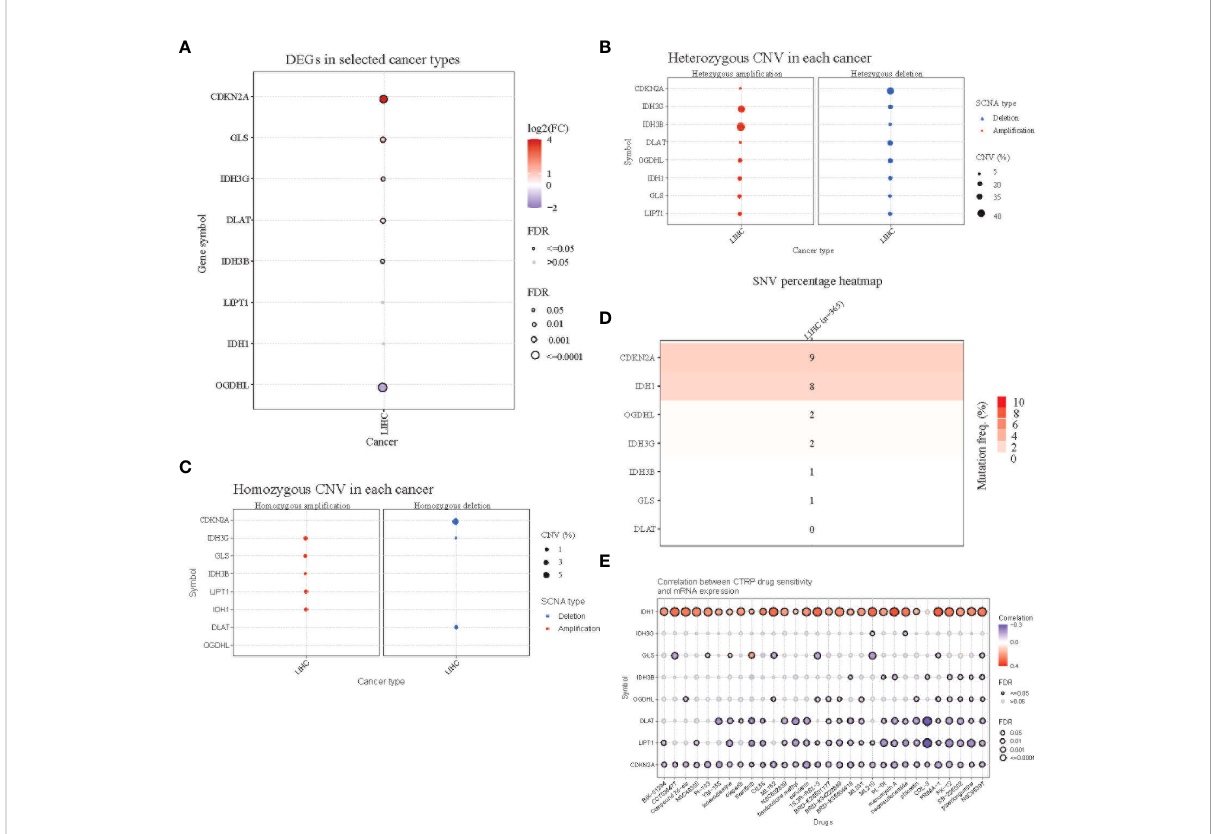
FIGURE 2 Mutation analysis of the 8-gene signature. (A) Differential expression of the eight genes in TCGA HCC tissues and normal adjacent tissues. Red (log2FC>1) indicates high expression, while blue indicates low expression. (B) Homozygous copy number variation of the eight genes in the TCGA HCC cohort. Ampli fi cations are shown on the left and deletions are shown on the right. (C) Heterozygous copy number variation of the eight genes in the TCGA HCC cohort. (D) Single nucleotide variant (SNV) variation of the eight genes in the TCGA HCC cohort. (E) Correlation analysis of the expression of the eight genes and drug sensitivity using the CTRP